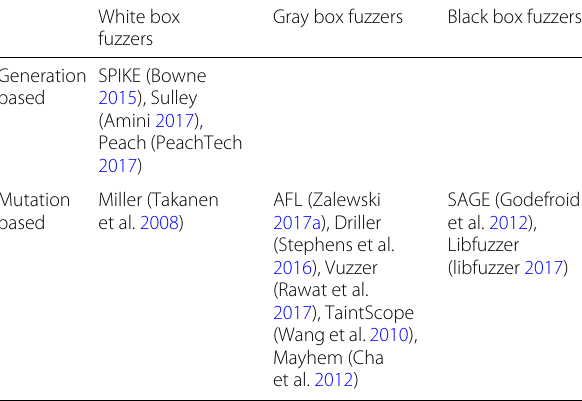
Table 3 Common white box, gray box and black box